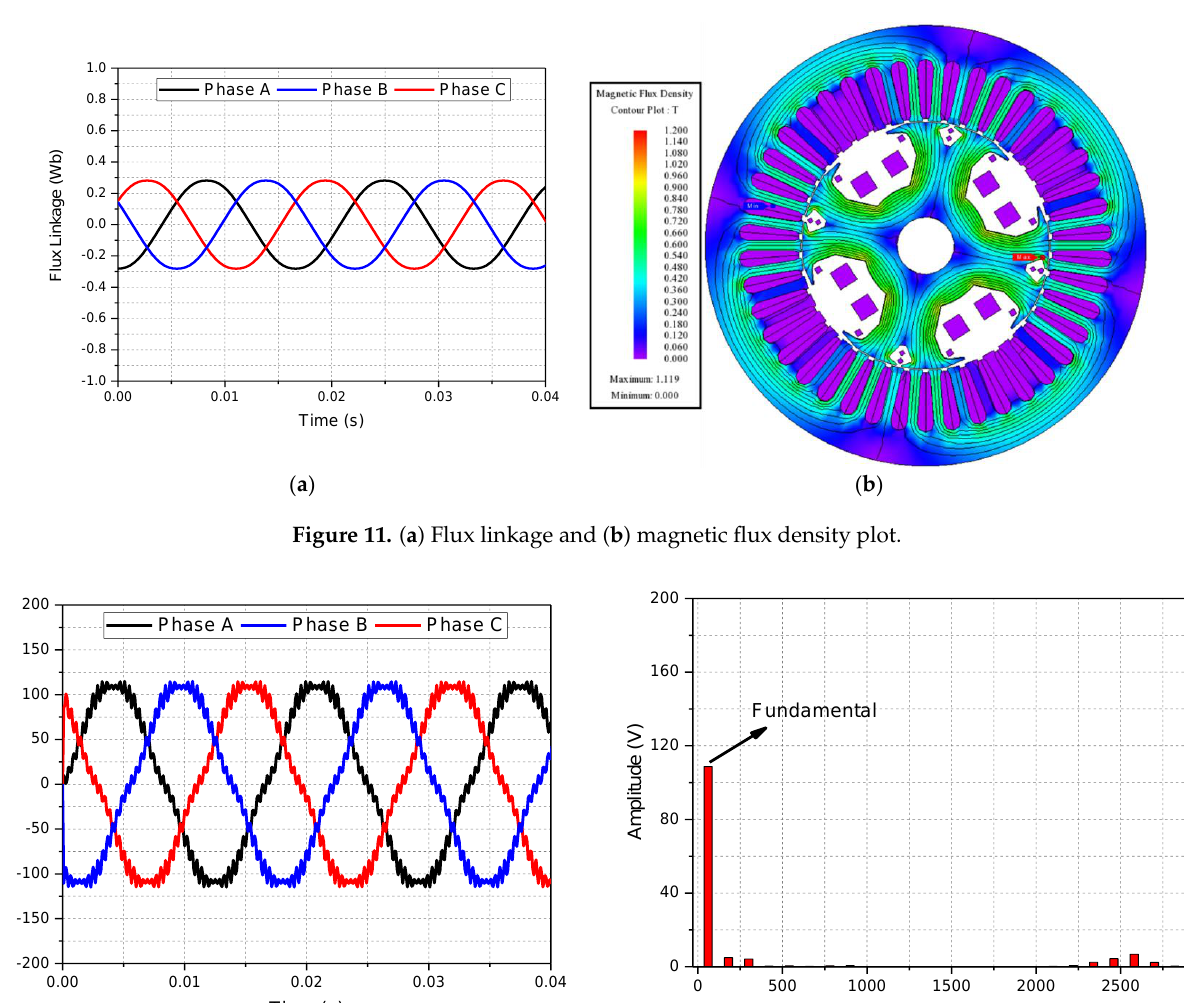
Figure 12. ( a ) Back-EMF of the employed machine and ( b ) its FFT plot.